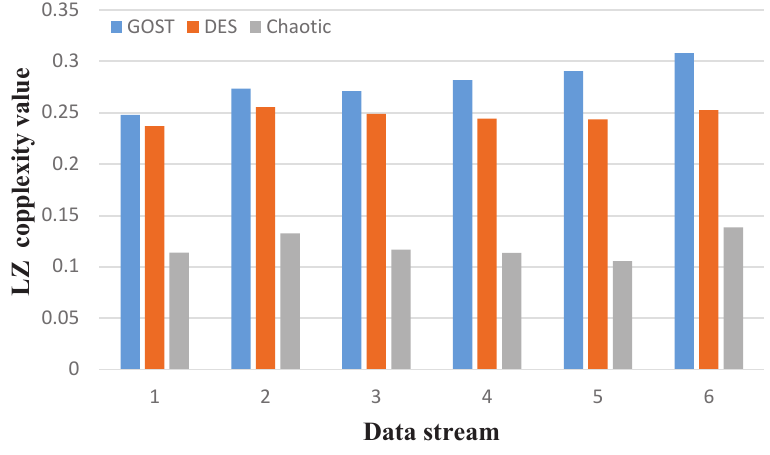
Figure 6. LZ complexity simulation results.